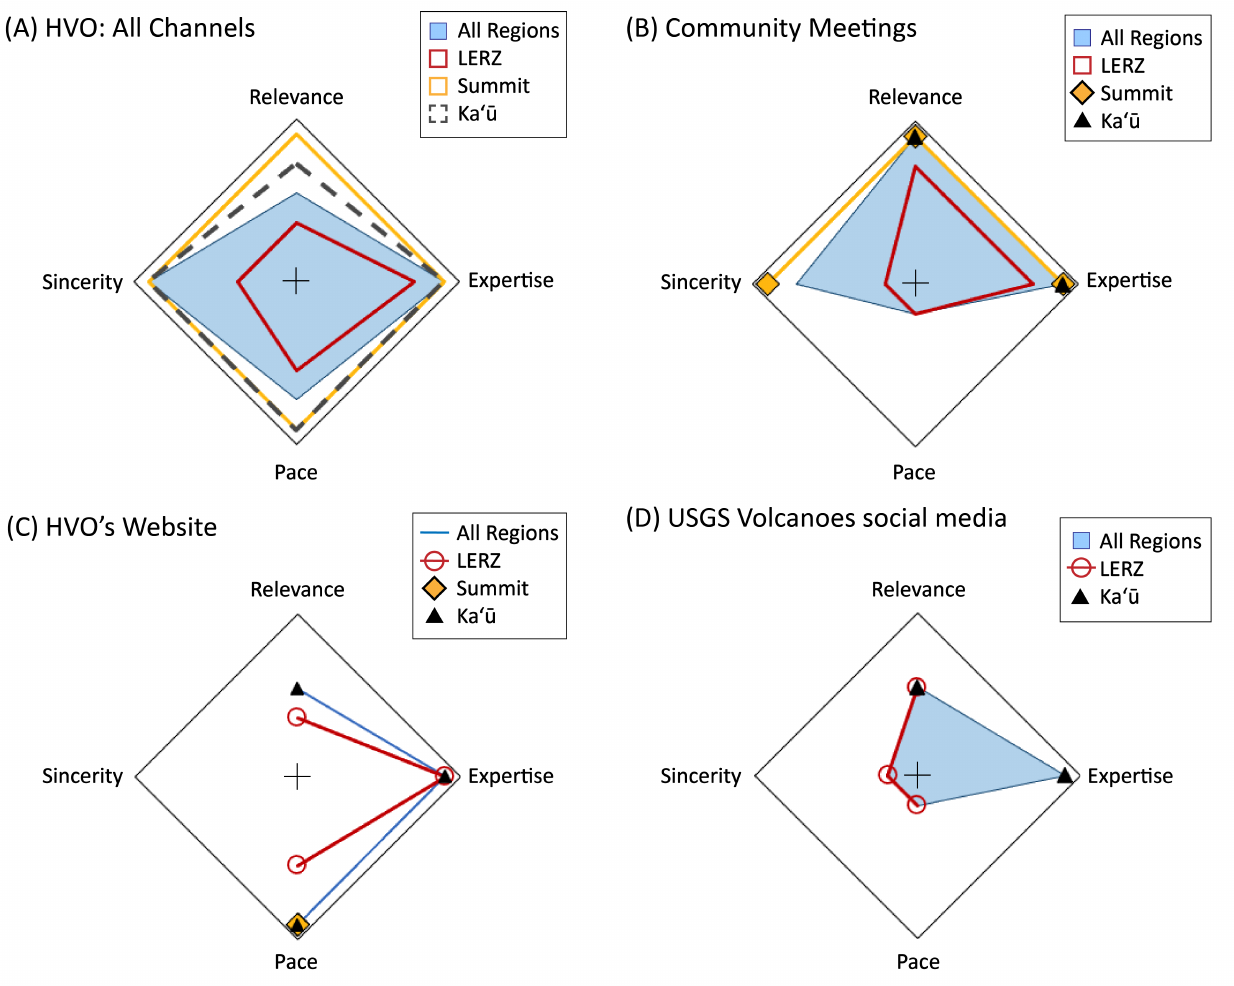
Figure 8: Radar charts illustrating participants’ perceptions of U.S. Geological Survey Hawaiian Volcano Observatory (HVO)’s performance communicating through [A] all channels (including press briefings and news media broadcasts), [B] community meetings, [C] HVO’s website, and [D] USGS social media channels identified by study participants. Plots include total and region- ally distinct feedback. Themes are plotted on a five-point scale: 1 = “consistently negative,” 2 = “mostly negative,” 3 = “mixed,” 4 = “mostly positive,” 5 = “consistently positive.” In lieu of axis tick marks (to avoid cluttering), the center of each chart is in- dicated with a +. Plots are left blank for themes lacking qualitative commentary; markers or open outlines plot the scores for the remaining themes. For specific scores, the reader is referred to Supplementary Material 2. No summit participants provided qualitative commentary for